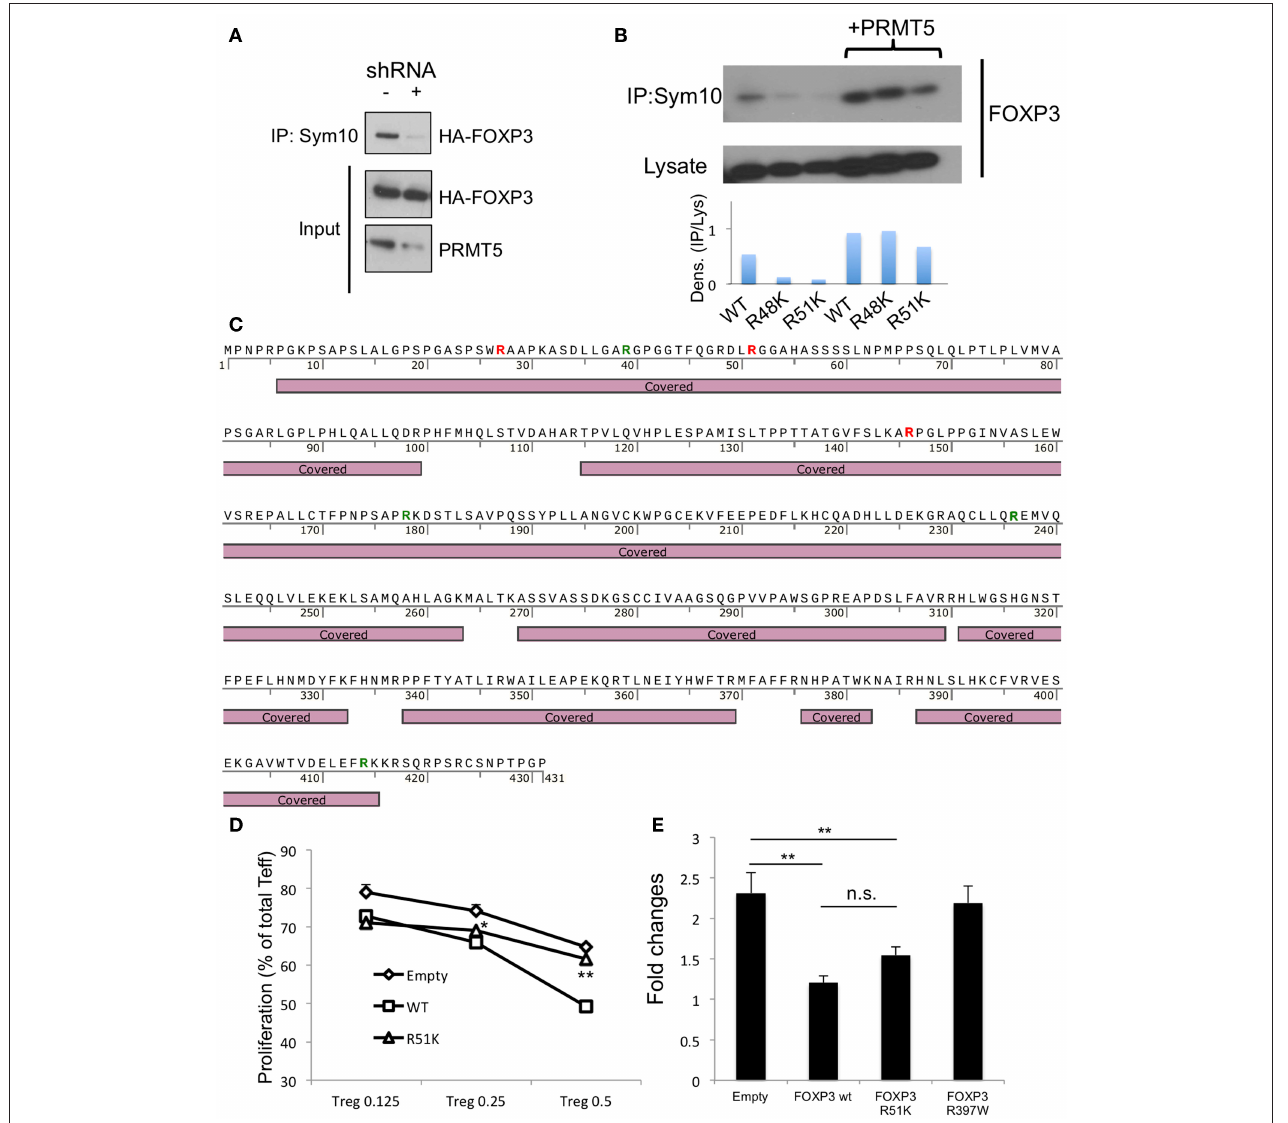
FIGURE 5 | Analysis of methylation sites in human FOXP3. (A) symmetrical methylation of FOXP3. 293T cells were transfected with FOXP3 and empty or PRMT5 shRNA86 vector. After 24h of transfection, the cells were lysed and immunoprecipitated with anti-sym10, which recognizes symmetrical arginine dimethylation, and then subjected to western blotting. (B) symmetrical methylation analysis of human FOXP3 wild type (WT), R48K and R51K mutant in 293T systems. (C) methylation analysis of FOXP3 by mass spectrometry. HA-FOXP3 transfected 293T cells were lysed and immunoprecipitated with anti-HA beads, then subjected for mass spectrometry. Covered: FOXP3 sequences detected by mass spectrometry. Red letters show the arginine that is di-methylated. Green letters show the arginine that is mono-methylated. (D) suppressive functions of FOXP3 R51K. Human CD4 + T cells were transfected with empty, FOXP3 WT and FOXP3 R51K mutant, then used as suppressors in the suppression assay. * P < 0.05, ** P < 0.01 with FOXP3 WT groups calculated by student t -test. (E) IL-2 promoter assay with FOXP3-transfected Jurkat cells. Jurkat cells were transfected with the IL-2 promoter vector and additional indicated vectors. Twenty four hours after transfection, cells were transferred